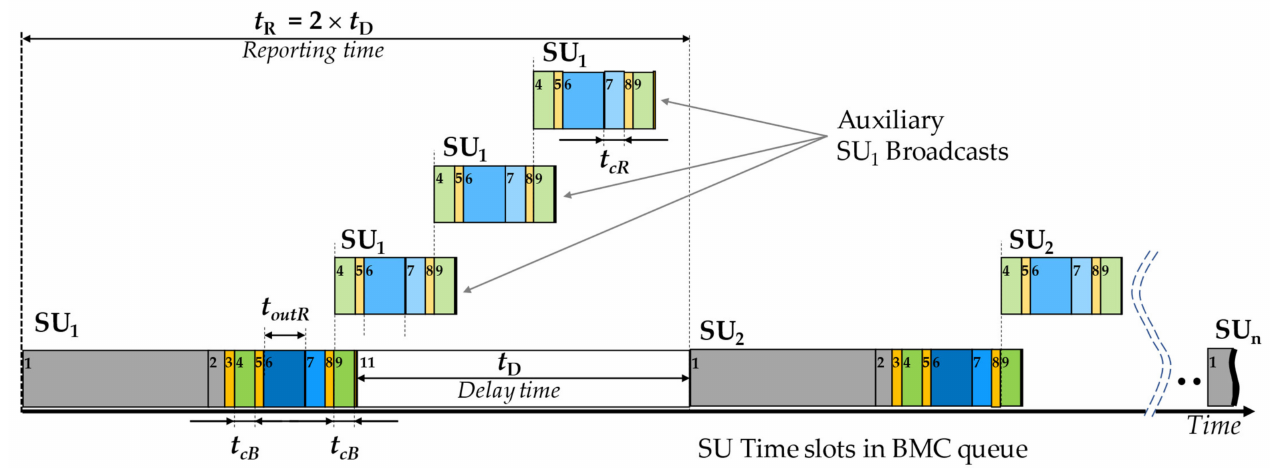
Figure 6. The timing diagram of the bidirectional synchronous communication protocol between SU and BMC (detailed description of symbols in the text of Sections 5 and